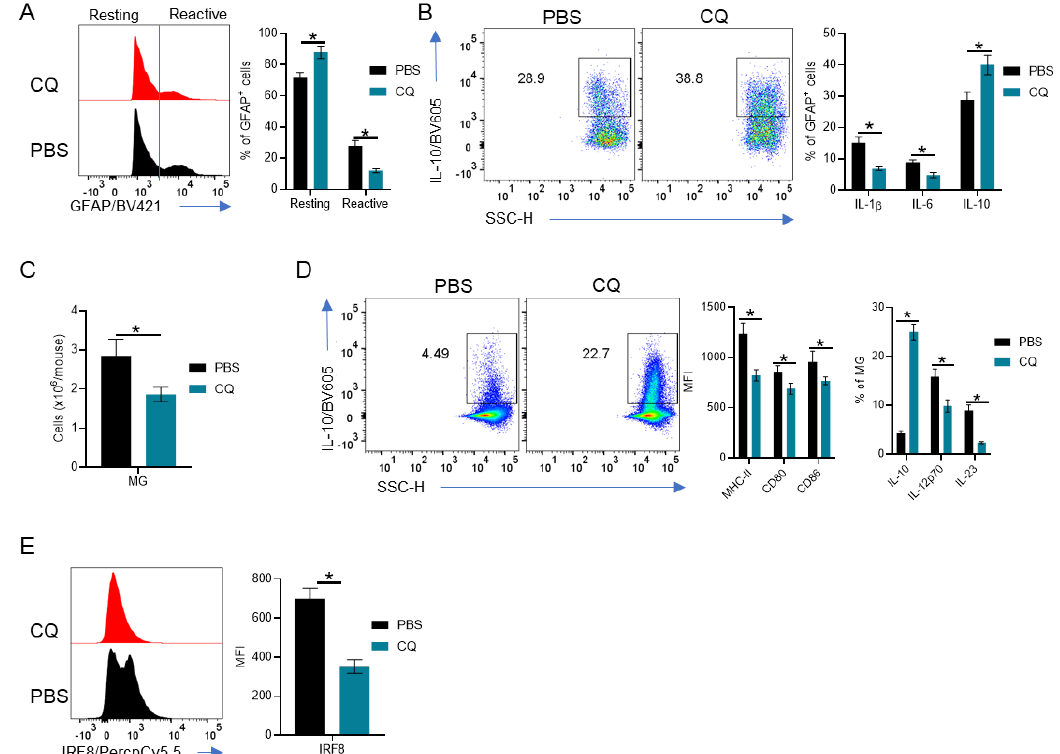
Figure 3. Comprehensive analysis of the stromal compartment in the CNS of CQ-treated mice. CNS cells from EAE B6SJLF1 mice ( n = 5/group) at day 21 post-immunization were analyzed by flow cytometry. ( A ) Analysis of resting (GFAP +/ low ) and reactive (GFAP high ) astrocytes. ( B ) Analysis of IL-1 β , IL-6 and IL-10 production by astrocytes. ( C ) Absolute numbers of MG (CD45 +/ low CD11b + Ly6C - ) in the CNS of CQ- and PBS-treated mice. ( D ) Analysis of the expression of the antigen-presenting molecules MHC-II, CD80 and CD86 and of the cytokine profile of MG. ( E ) IRF8 expression in MG from CQ- and PBS-treated mice. Values of p < 0.05 (*) were considered statistically significative. Results are from three independent experiments.